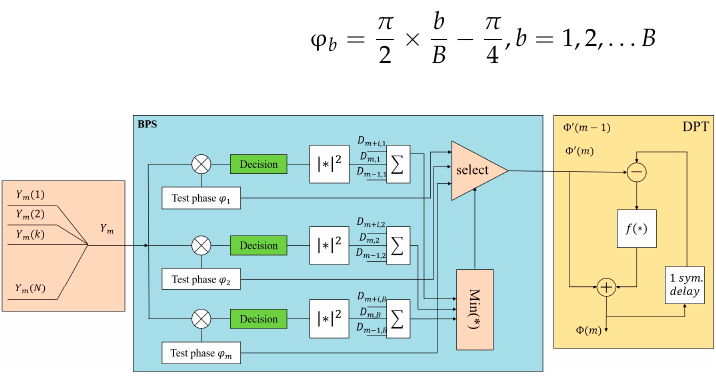
Figure 3. Block of BPS algorithm.